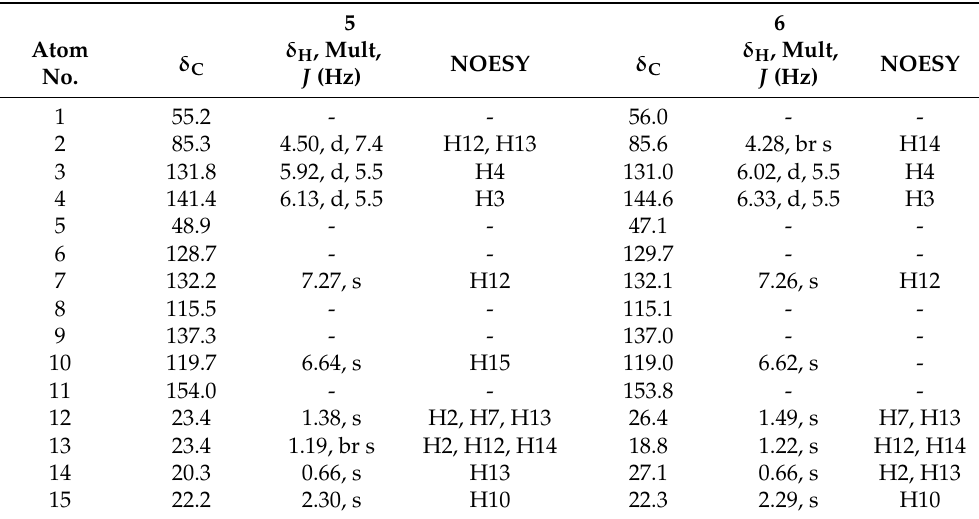
Table 2. NMR spectroscopic data for compound 6 as a mixture with 5